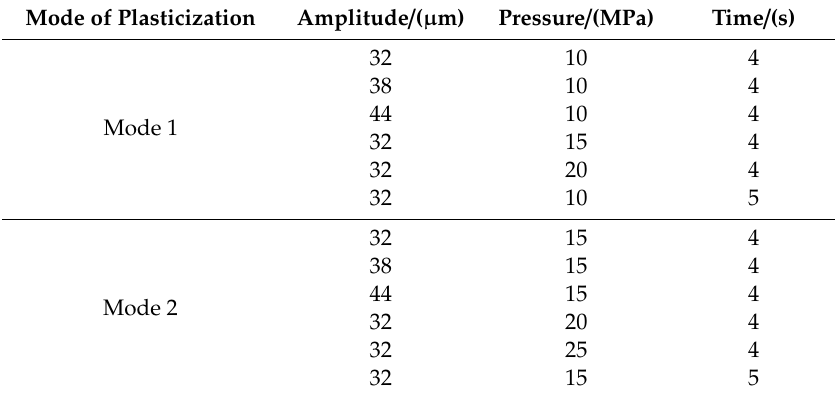
Table 4. Parameter combinations for sample preparation under Mode 1 and Mode